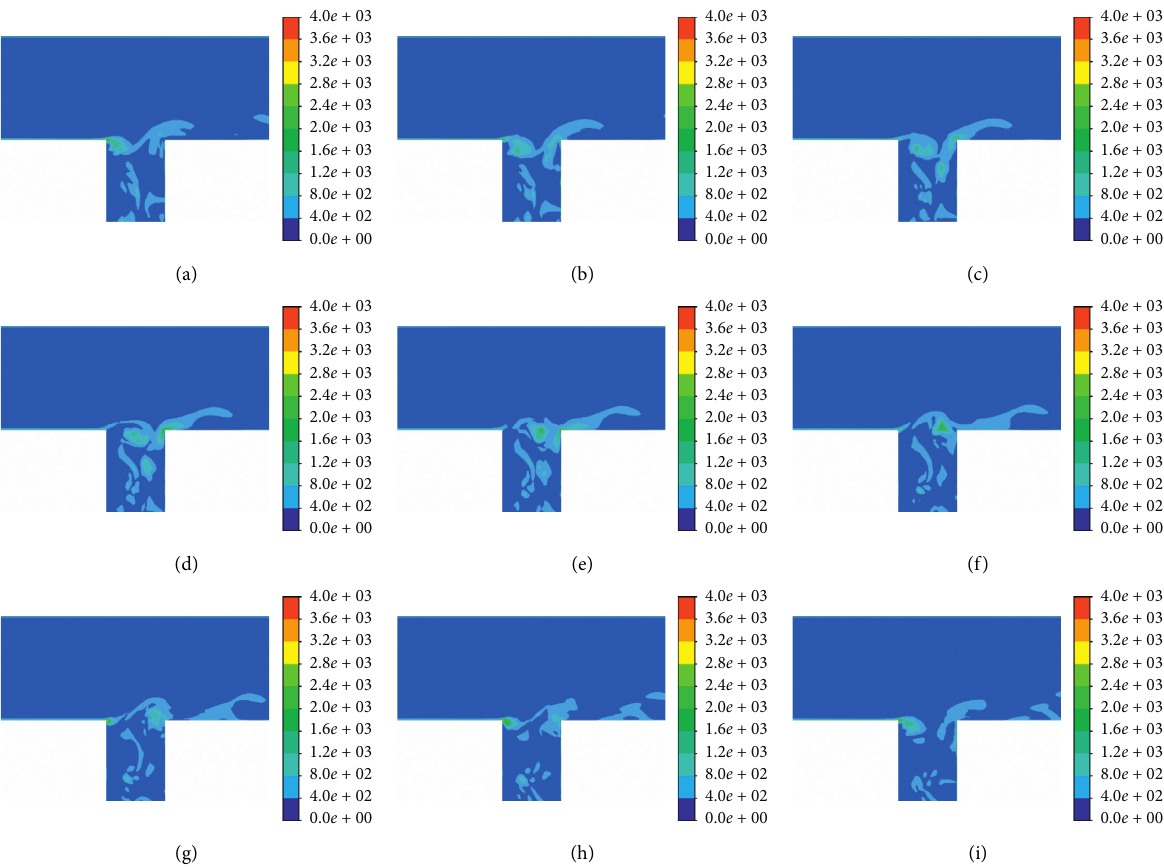
Figure 12: Vorticity ( t 2 � 0.6123–0.6323s unit: s − 1 ): (a) 0T/8, (b) 1T/8, (c) 2T/8, (d) 3T/8, (e) 4T/8, (f) 5T/8, (g) 6T/8, (h) 7T/8, and (i)